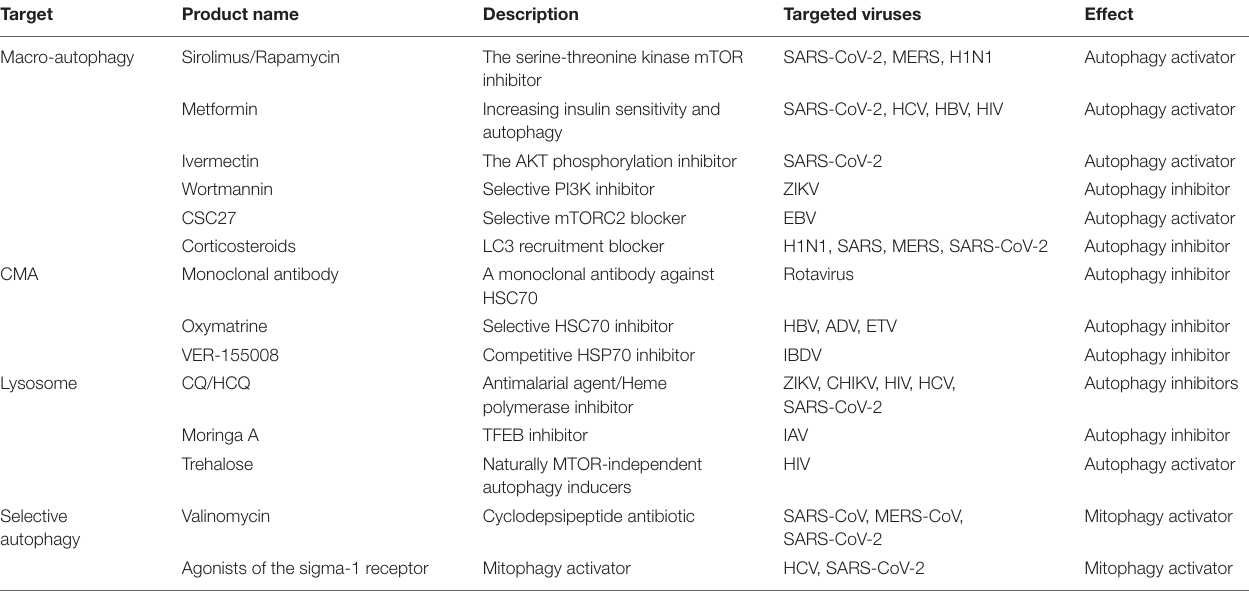
TABLE 3 | Antiviral therapy targeting autophagy/selective